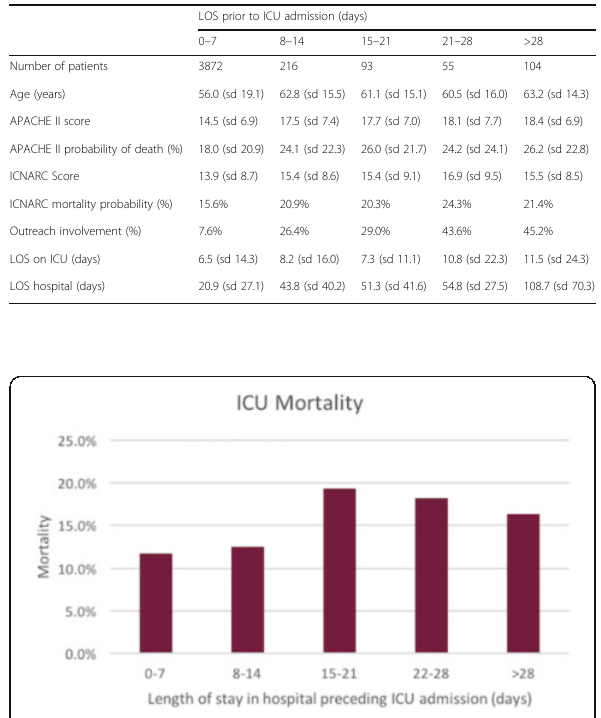
Fig. 138 (abstract A352). ICU Mortality vs Preceding ward Length of